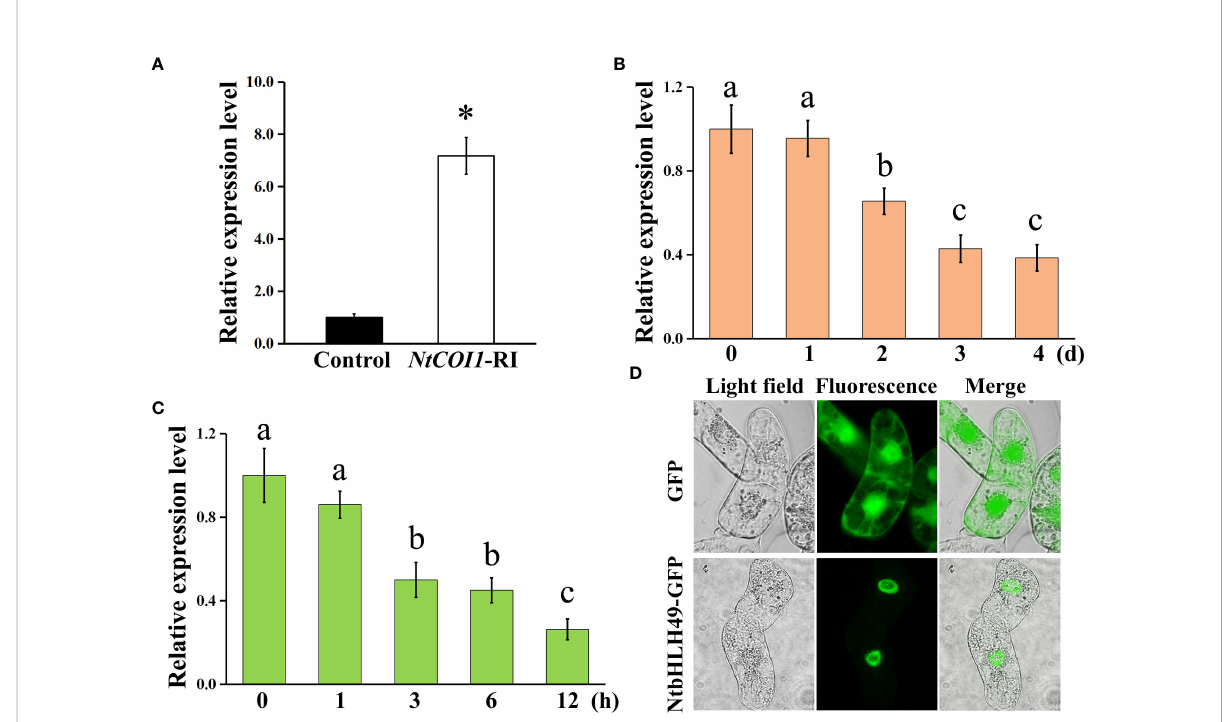
FIGURE 4 Gene expression pattern and subcellular localization of NtbHLH49. (A) Relative expression of NtbHLH49 in control and NtCOI1 -RI plants. (B) Relative expression of NtbHLH49 in tobacco leaves after different time of P. nicotianae infection. (C) Relative expression of NtbHLH49 in tobacco leaves after different time of MeJA treatment. Actin gene was used as an internal control. The expression level of NtbHLH49 in control plants (A) or the time point ‘ 0 ’ (B, C) was set as “ 1 ” . Data are shown as means ± SD (n = 3). Asterisk in (A) indicates signi fi cant difference from control (Student's t- test; P<0.05). Lower-case letters (i.e., a, b, and c) in (B – C) indicate signi fi cant difference among the values (p<0.05). (D) Subcellular localization of NtbHLH49-GFP fusion protein and GFP alone (control) in BY2